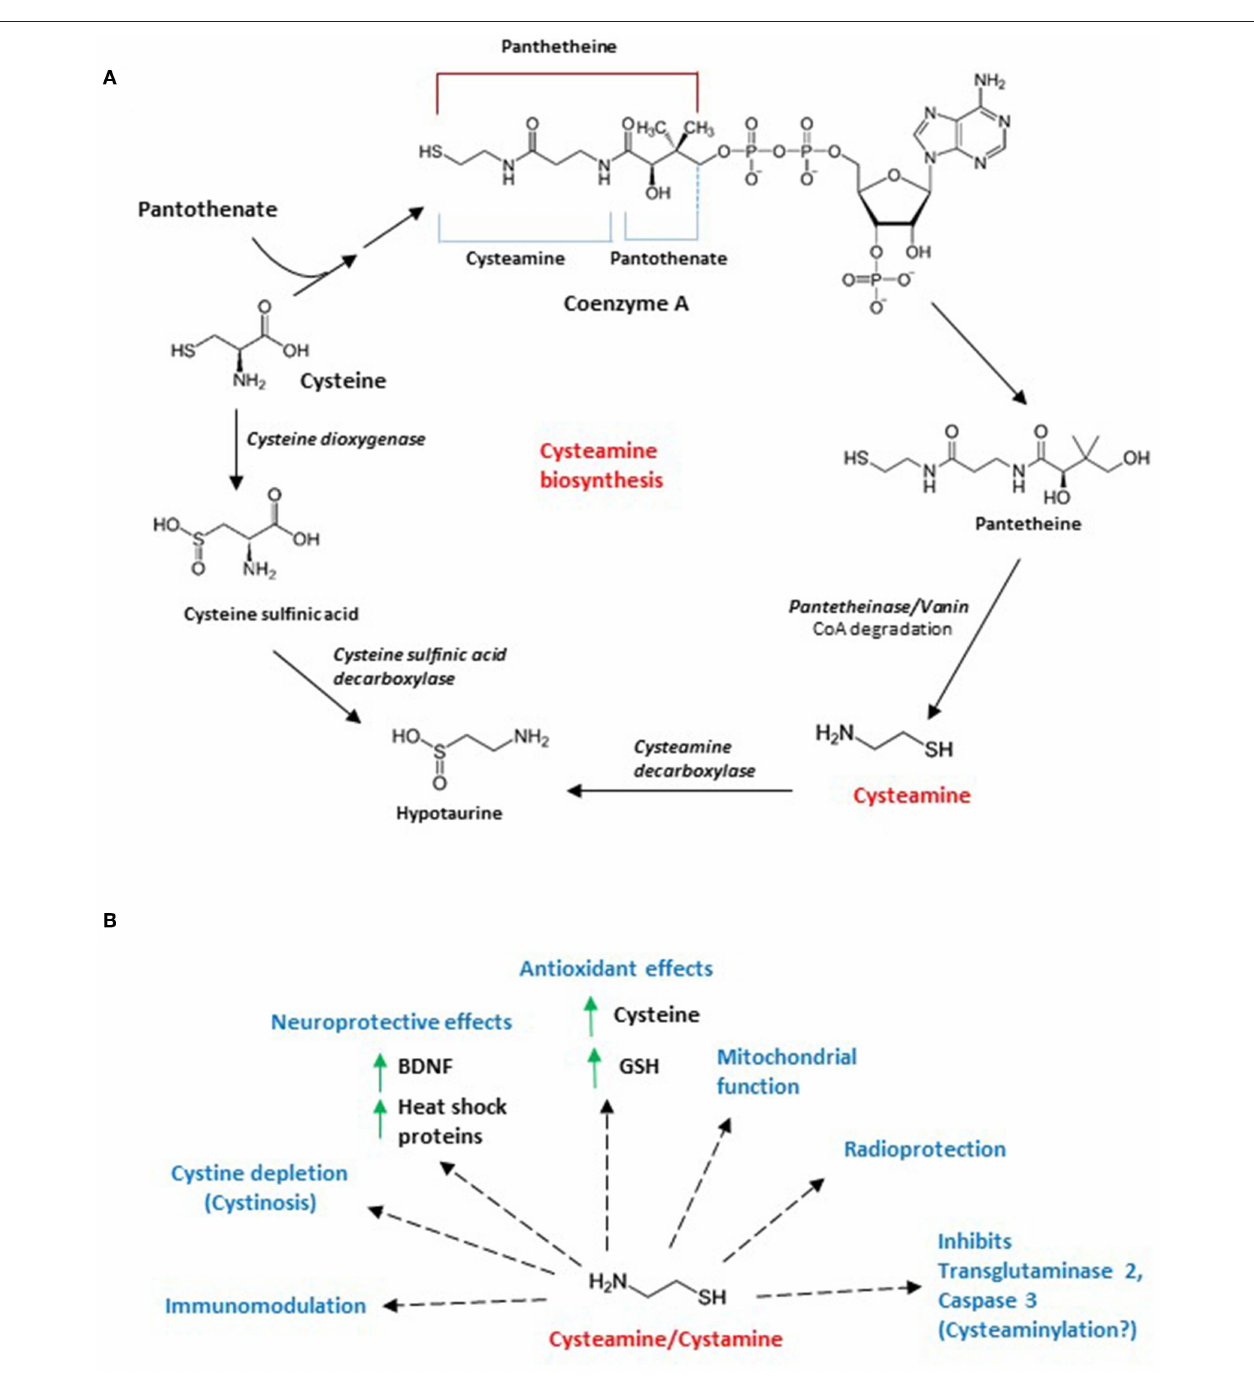
FIGURE 1 | (A) Biosynthesis of cysteamine and intersection with cysteine catabolism. Cysteamine is generated in mammals by the degradation of coenzyme A, which is required for the metabolism of fatty acids, carbohydrates, amino acids and ketone bodies. When coenzyme A is cleaved (cleavage at the dotted line), pantetheine is generated, which is acted on by pantetheinase or vanin to form cysteamine. Cysteamine is converted to hypotaurine by cysteamine decarboxylase. Cysteine, a component of coenzyme A, is acted on by cysteine dioxygenase to form cysteine sulfonate which is decarboxylated by cysteine sulfonate decarboxylase to form hypotaurine. Hypotaurine generated is further metabolized to taurine by hypotaurine decarboxylase. (B) Effects of cysteamine/cystamine. Both cysteamine and its oxidized form cystamine have protective effects in cells and tissues. Originally identified as radioprotective molecules, subsequently these aminothiols have been reported to mitigate cystinosis, a condition characterized by accumulation of cystine crystals in the body. Cystamine and cysteamine have a variety of other effects which include antioxidant effects (by increasing cysteine and glutathione levels), inhibition of transglutaminase 2 and caspase 3 (possibly by modifying reactive cysteine residues or cysteaminylation), modulation of mitochondrial function, immunomodulation. These molecules have also been reported to increase levels of brain derived neurotrophic factor (BDNF) and heat shock proteins, which affords neuroprotective benefits.